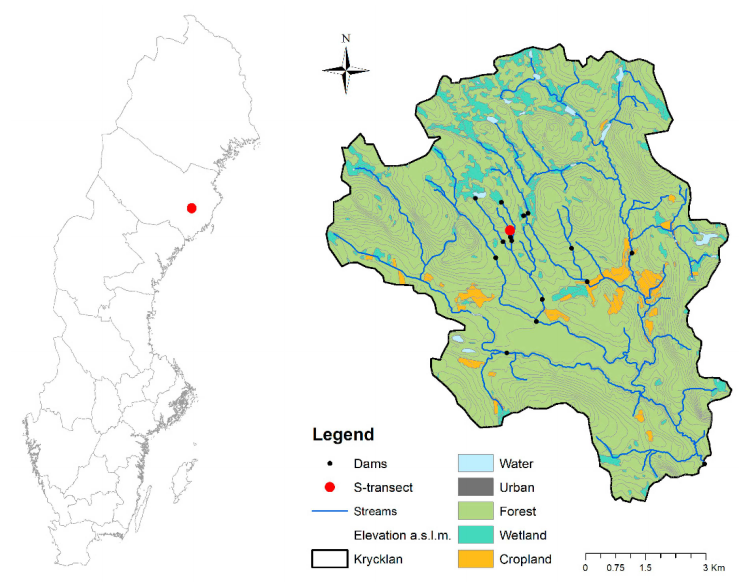
Figure 3. Location of the S-transect in Sweden and in the Krycklan